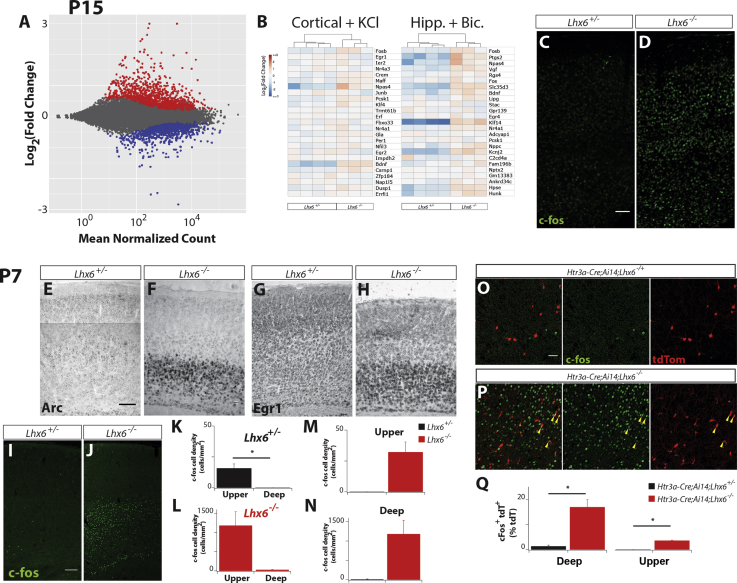
Molecular Analysis of Lhx6 Mutant Forebrains Reveal Widespread Upregulation of Activity-Dependent Genes(A) MA plot summarizing the results of the differential expression analysis between Lhx6+/− and Lhx6−/− P15 forebrains. Significantly upregulated genes are shown in red (977 genes), whereas significantly downregulated genes are shown in blue (730 genes). Significance was set as a false discovery rate of ≤ 0.05.(B) Hierarchical clustering of Lhx6+/− and Lhx6−/− forebrain samples using activity-regulated genes. Clusters were generated using the expression levels of the 25 most significantly upregulated genes in either cortical cultures treated with KCL + FPL64176 (Qiu et al., 2016) or hippocampal cultures treated with bicuculline (Yu et al., 2015). Genes upregulated by either treatment are similarly upregulated upon deletion of Lhx6.(C and D) Coronal sections from the somatosensory cortex of Lhx6+/− (C) and Lhx6−/− (D) P15 mice immunostained for cfos (green).(E–H) In situ hybridization of somatosensory cortex sections from Lhx6+/− (E and G) and Lhx6−/− (F and H) P7 mice with either Arc (E and F) or Egr1 (G and H) riboprobes shows immediately early gene upregulation in the bottom layers of mutant brains.(I and J) Coronal sections of the somatosensory cortex of Lhx6+/− (I) and Lhx6−/− (J) P7 mice immunostained for cfos (green); note the upregulation of cfos expression, particularly in the lower half of the cortex.(K–M) Quantification and distribution of cfos+ cell density in upper (M) and deep (N) areas of Lhx6+/− (K) and Lhx6−/− (L) cortices.(O and P) High-magnification images of the bottom half of the somatosensory cortex of Htr3a-Cre;Ai14;Lhx6+/− (O) and Htr3a-Cre;Ai14;Lhx6−/− (P) P7 brains immunostained for cfos (green). Yellow arrowheads show examples of cfos-expressing CGE-derived tdT+ cells.(Q) Quantification of the distribution of cFos+ tdT+ (CGE-derived CIs) in the cortex.See Table S2 for a summary description of mRNA sequencing results for the genes highlighted in (A) and Table S3 for a summary of results of the RT2 profiler PCR array for CGE-derived CIs isolated by fluorescence-activated cell sorting (FACS) from P7 cortices. Scale bars are 100 μm for (C)–(J) and 50 μm for (O) and (P).